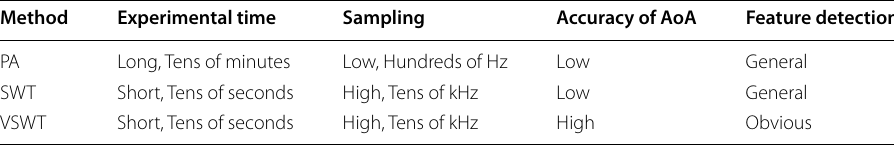
Table 2 Comparison of three transition detection